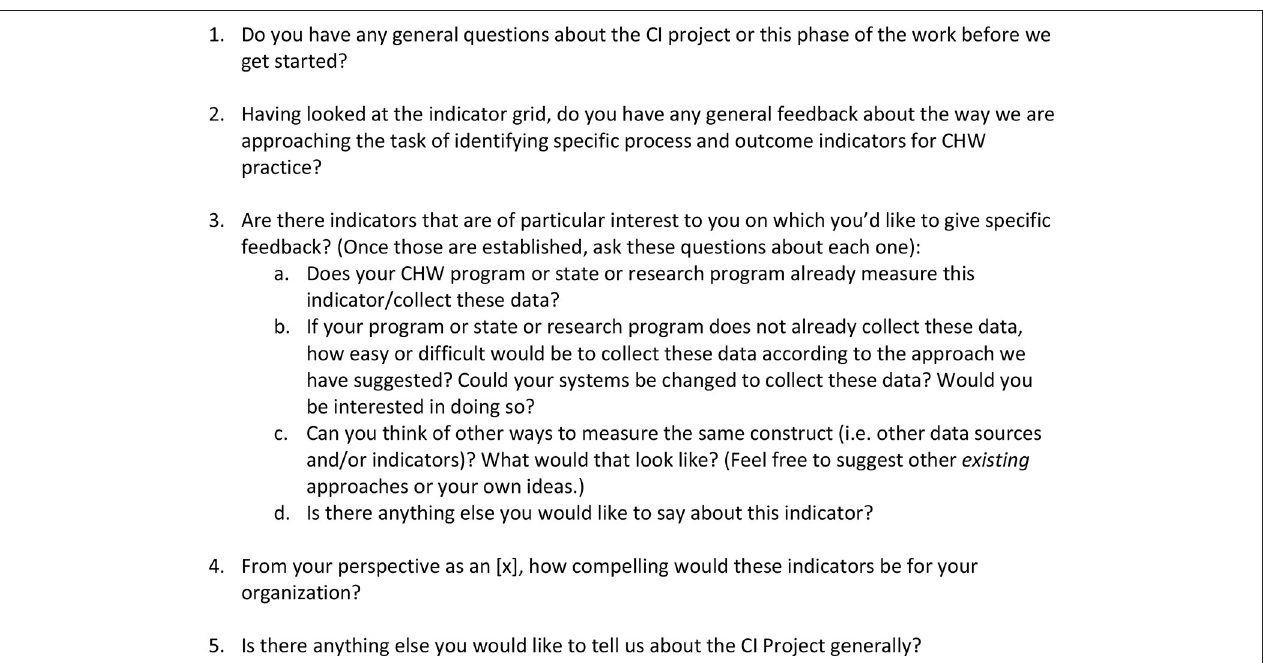
FIGURE 1 | Individual interview